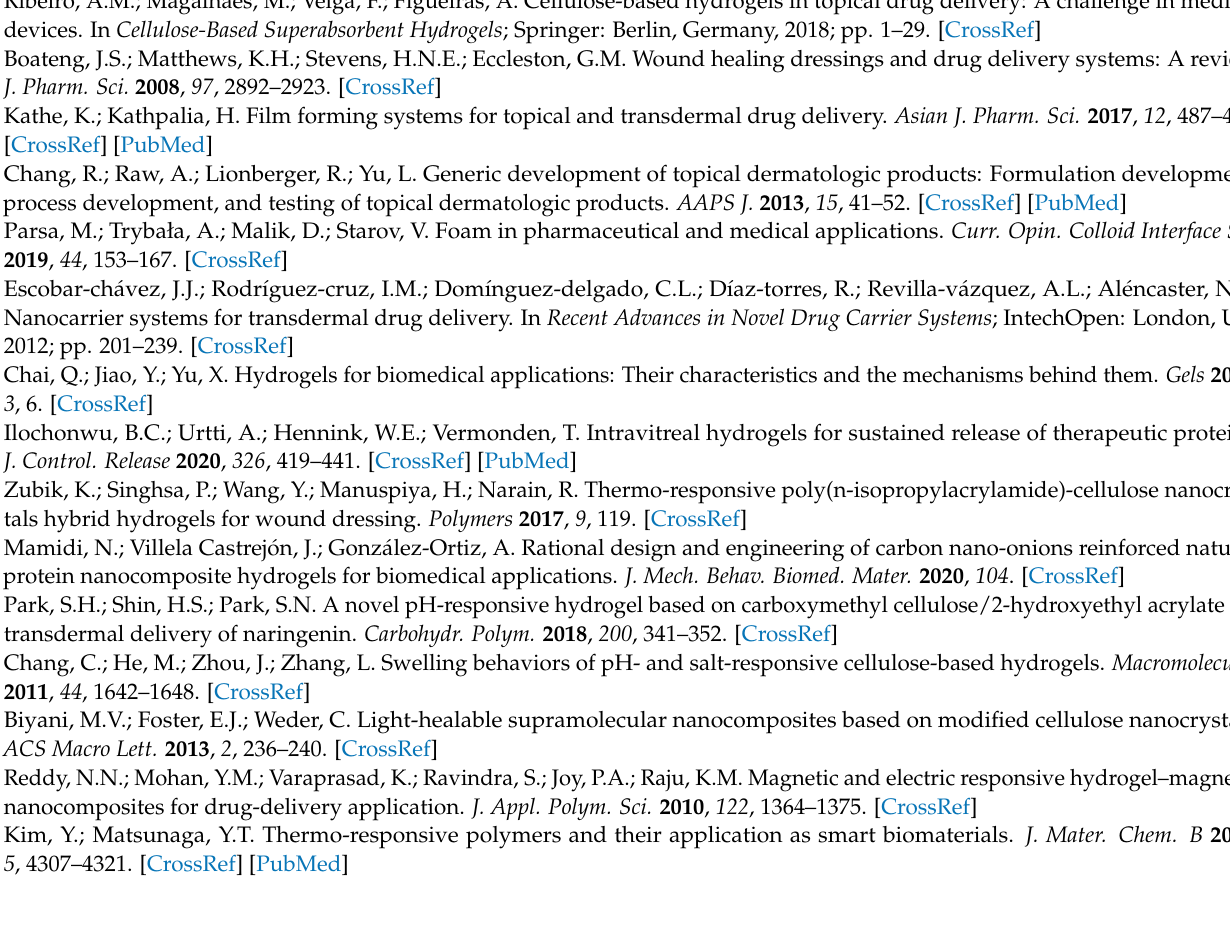
10.3390/polym13132153/s1, Figure S1: Schematic illustration of PF127 micelles formation and its interaction with OPEFB extracted cellulose for the synthesis of thermo-responsive cellulose hydrogel. Figure S2: Swelling mechanism of thermo-responsive cellulose hydrogel. Figure S3: Linear regression of kinetic and mechanism models (a) Zero-order model (b) First-order model (c) Higuchi model (d) Korsmeyer- peppas model. Figure S4: SSD release from thermo-responsive cellulose hydrogels by different mechanisms. Table S1: Concentration of SSD released from thermo-responsive cellulose hydrogels at different time